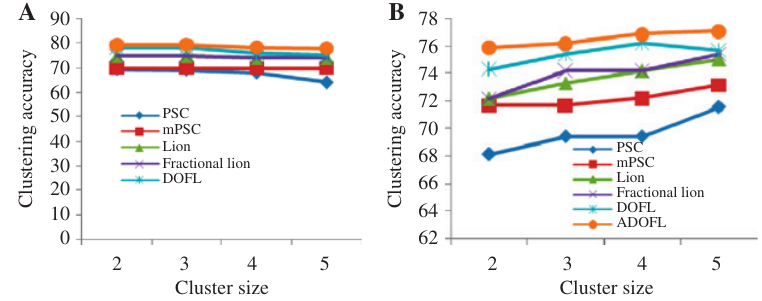
Figure 4: Clustering Accuracy Analysis Curve. (A) Iris dataset. (B) Wine